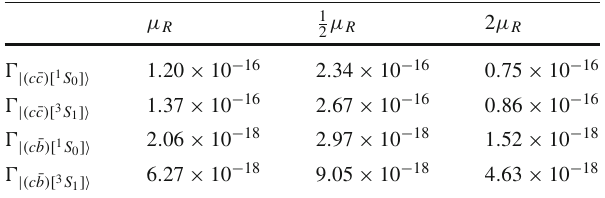
Table 5 Scale uncertainties of the decay width for the process t → | ( c ¯ Q ) [ n ](cid:5) + Q + Z 0 by varying the typical renormalization scale μ μ μ μ = 2 m from 1 R to 2 R . R c for charmonium and 2 (